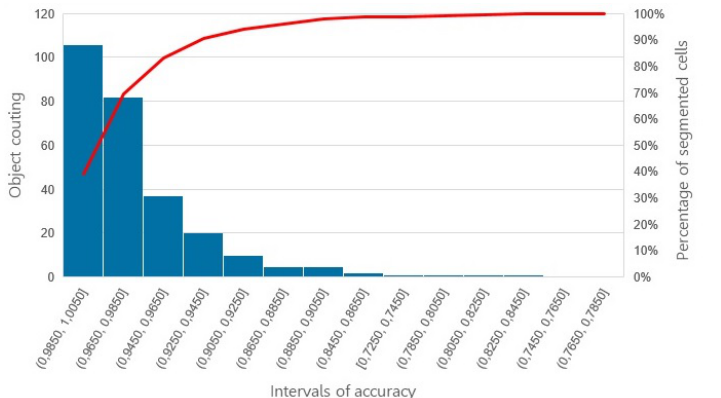
Figure 10. Pixel-wise accuracy of cell segmentation with the proposed method. Objects accuracy is subdivided into intervals. The Pareto chart shows that our method offers high pixel-wise accuracy for the majority of the objects and that more than 90% of the total cells are segmented with a pixel-wise accuracy of more than 95%.